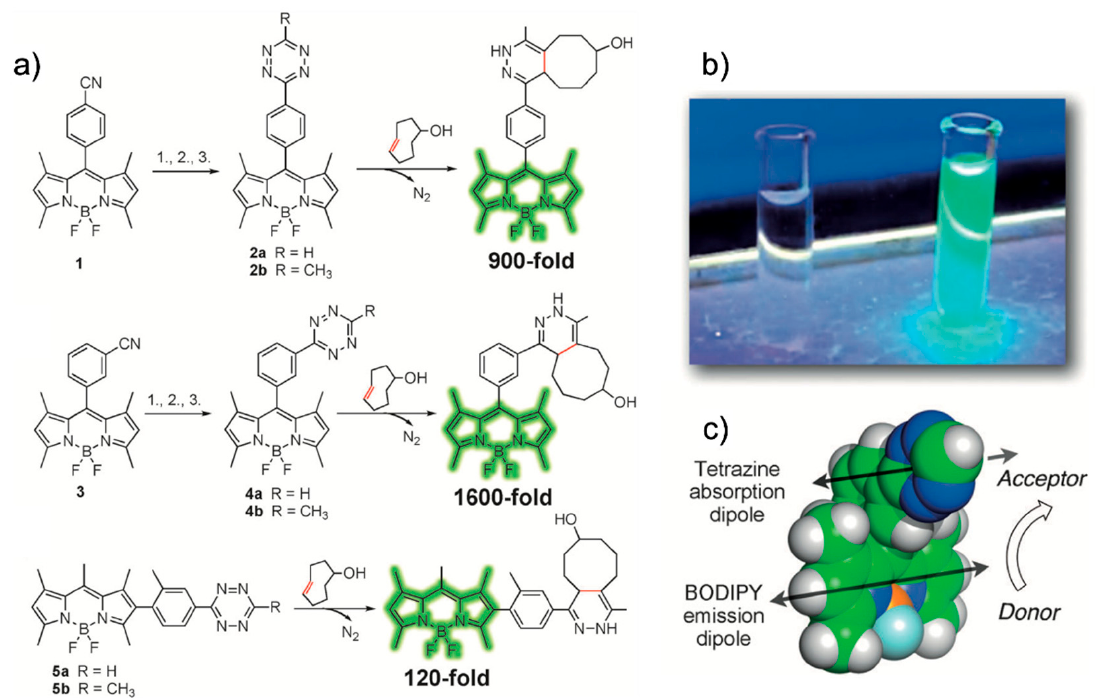
Figure 4. Synthesis of a tetrazine-functionalized fluorophore via a through-bond energy transfer (TBET) strategy. ( a ) Syn- thetic scheme of BODIPY- p -tetrazine derivatives and schematic representation of the fluorogenic reaction with trans -cy- clooctene (TCO). ( b ) Photographs of BODIPY-tetrazine probes without (left) and with (right) TCO, upon excitation under a handheld UV lamp. ( c ) Schematic representation of the orientation of the donor (BODIPY core) and acceptor (tetrazine) transition dipoles. Reproduced from [41] with permission from Wiley-VCH.